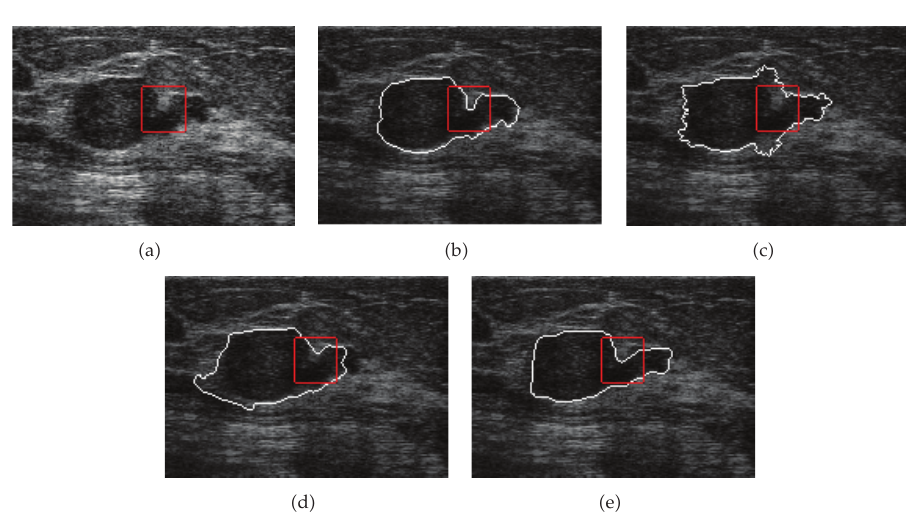
Figure 6: Segmentation of a malignant breast tumor with intensity inhomogeneity and highly concave boundary. (cid:3) a (cid:4) Original image. (cid:3) b (cid:4) Golden standard. Segmentation results of (cid:3) c (cid:4) GAC (cid:5) 11 (cid:6) , (cid:3) d (cid:4) DRLSE (cid:5) 16 (cid:6) , and (cid:3) e (cid:4) the proposed PGBLSE models.